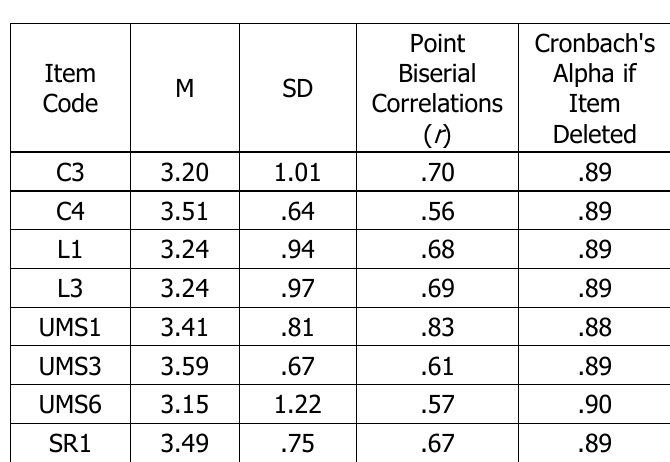
The Item Total Statistics for Form